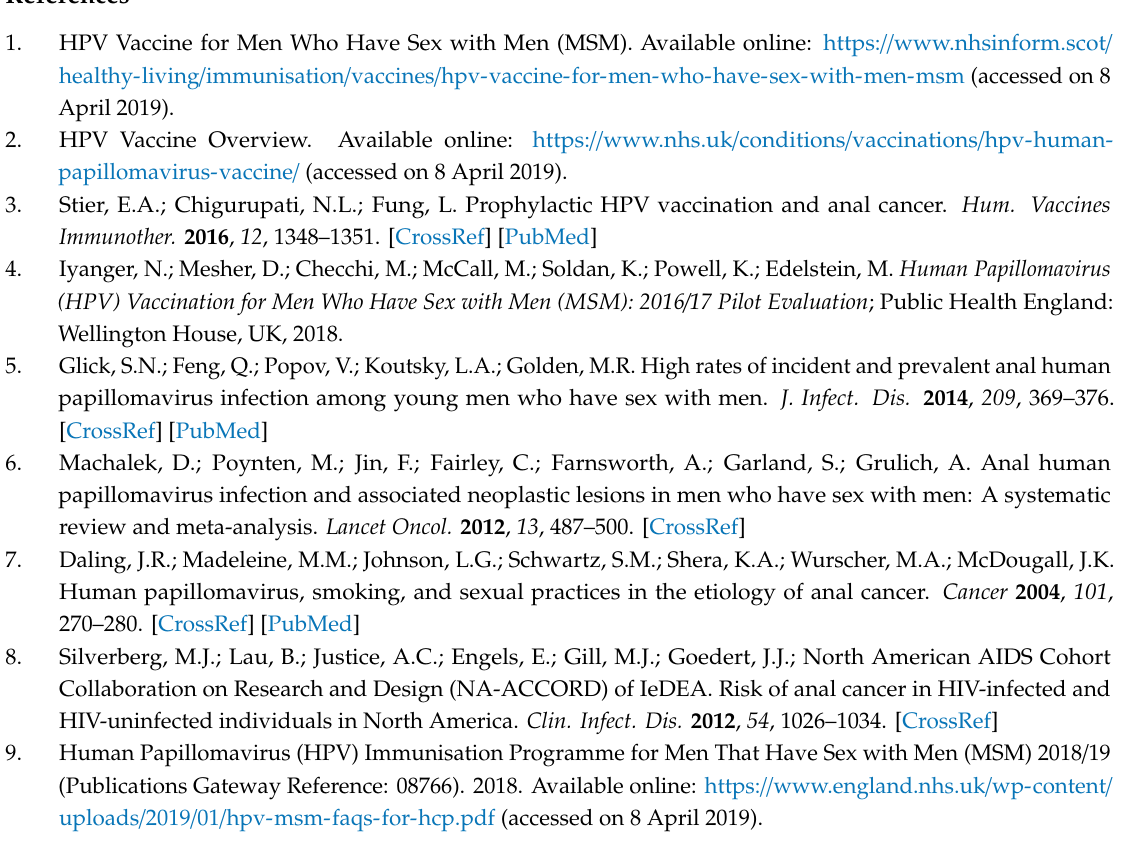
Table S1: The questionnaire used in the present research, Table S2: Information on how variables were recoded, Dataset [dataset is currently being made available via the UCL data